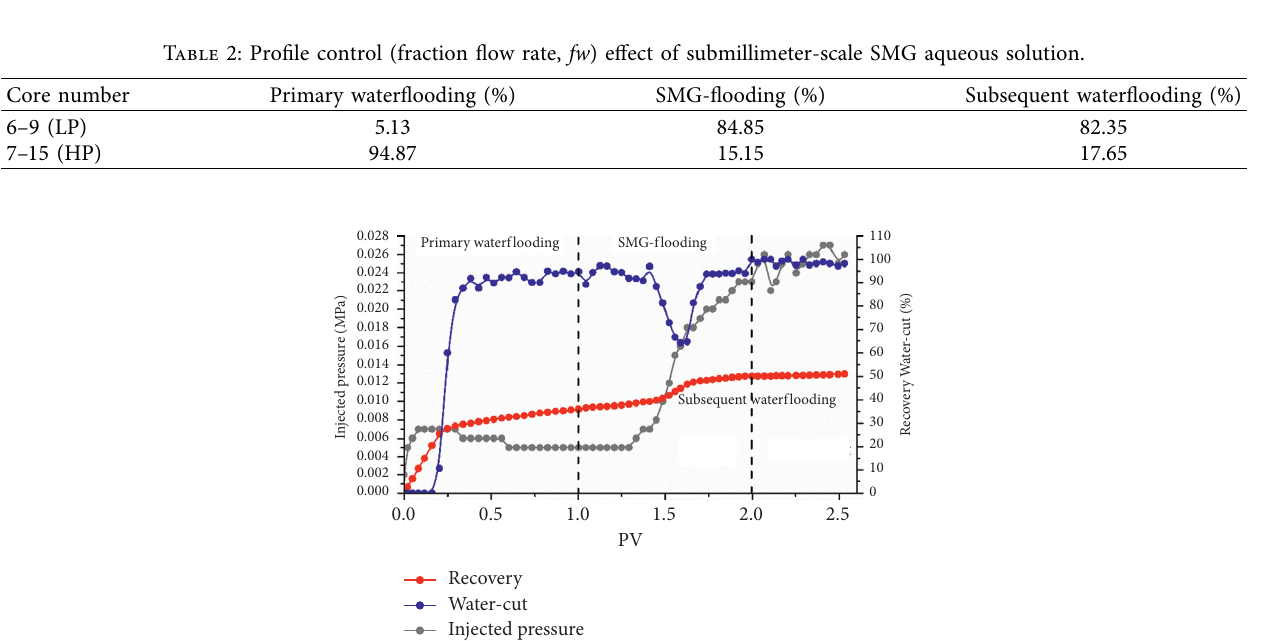
Figure 1: The relation curve of recovery, water-cut, and injected pressure with the increase of injection pore volume.